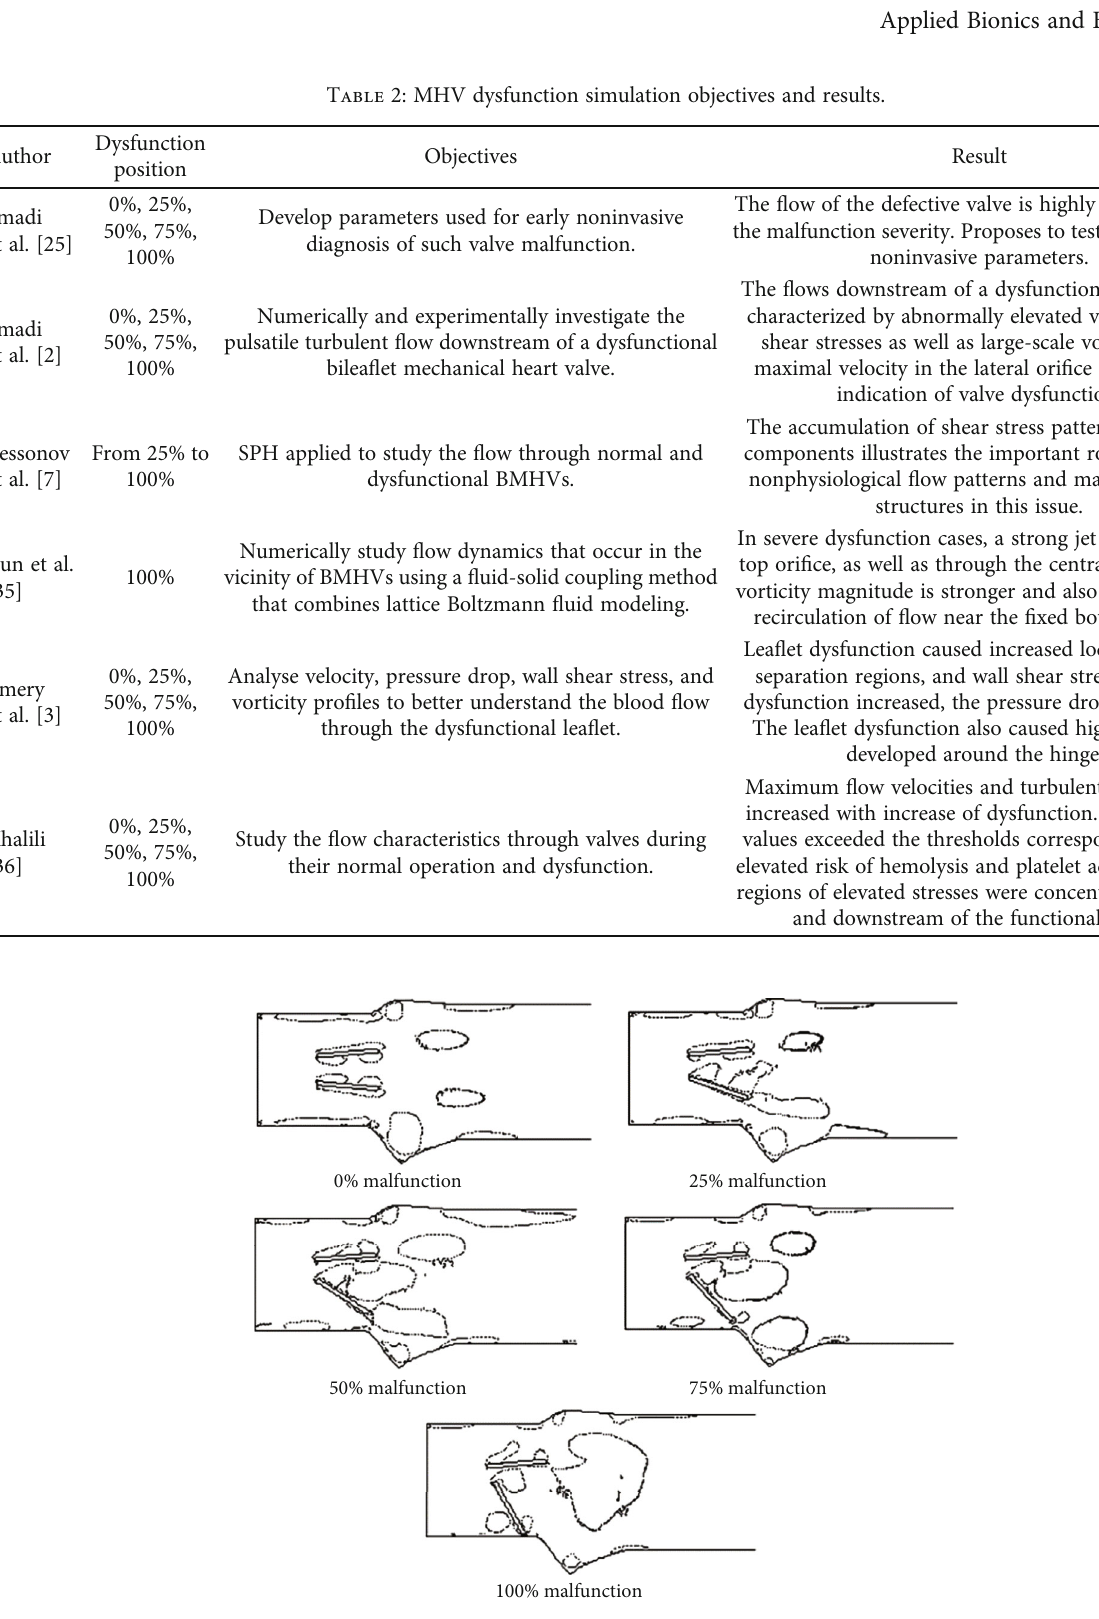
Figure 2: Coherent structure downstream of a normal and a defective mechanical valve for 7 L/min